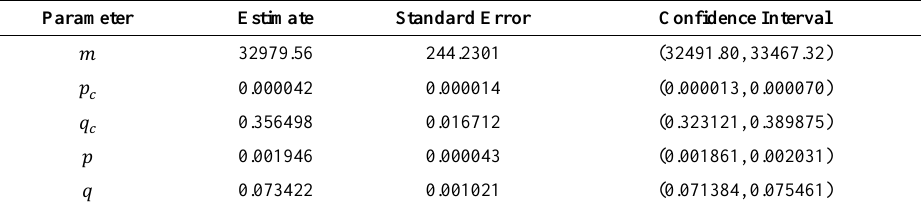
Table A16. Piedmont. Estimates, asymptotic standard errors and 95% mCIs for the parameters of the DMP (8).